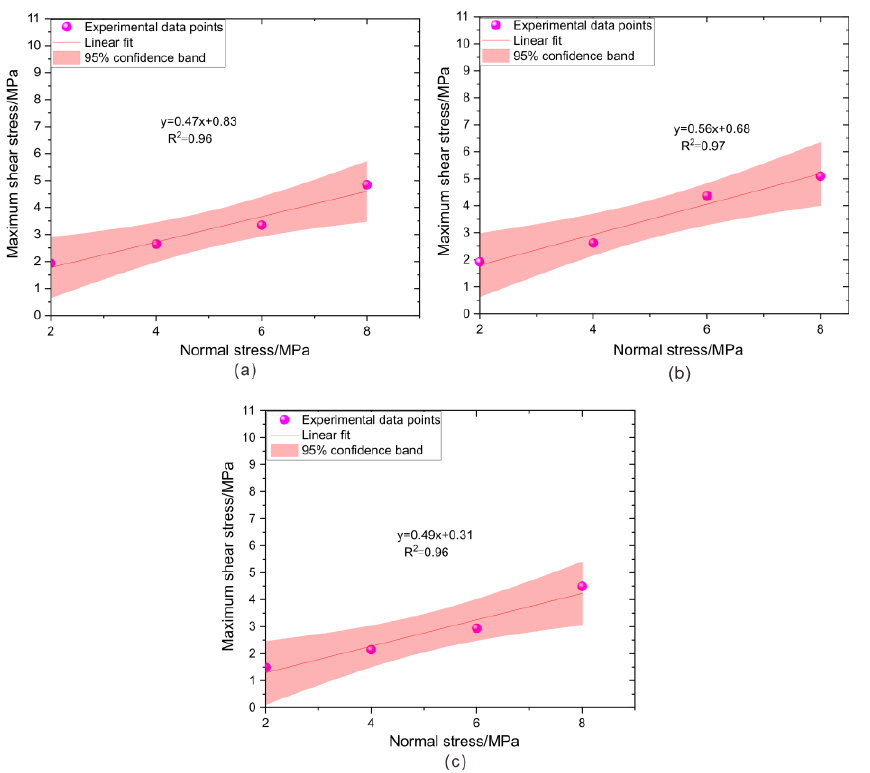
Figure 14. The linear fitting relationship between the shear strength and the normal stress of the fault rocks with three types of fault gouge (( a ) is No. 1 fault gouge, ( b ) is No. 2 fault gouge, ( c ) is No. 3 fault gouge) and the tensile fault plane.